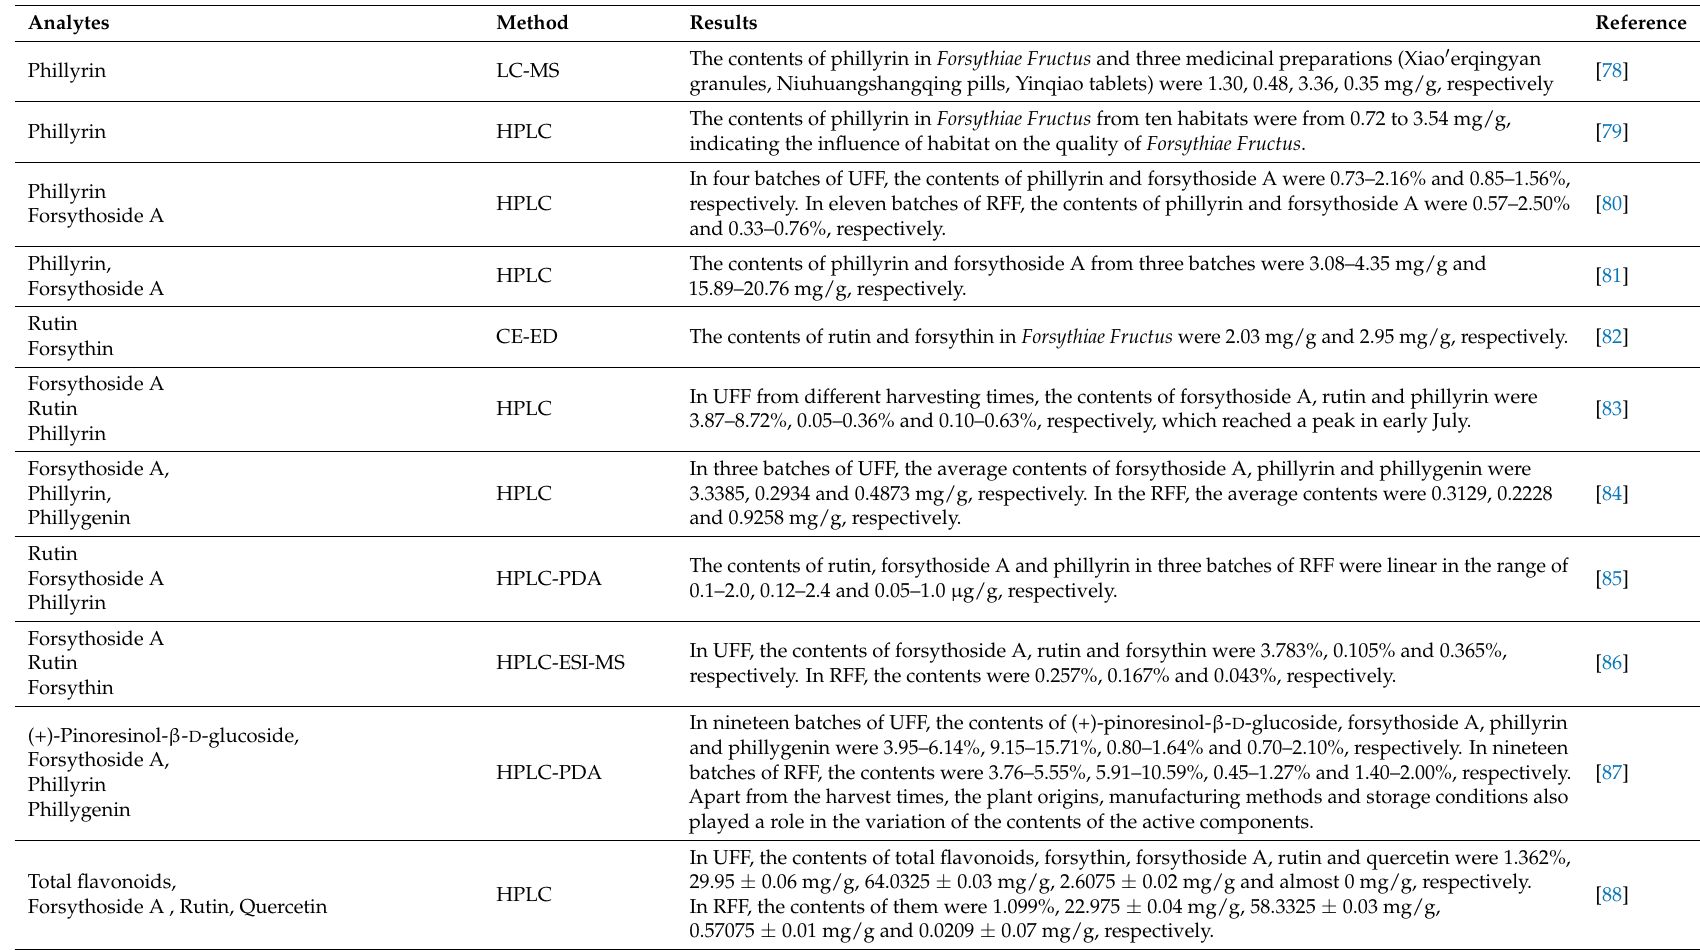
Table 2. Quantitative analysis for the quality control of Forsythiae